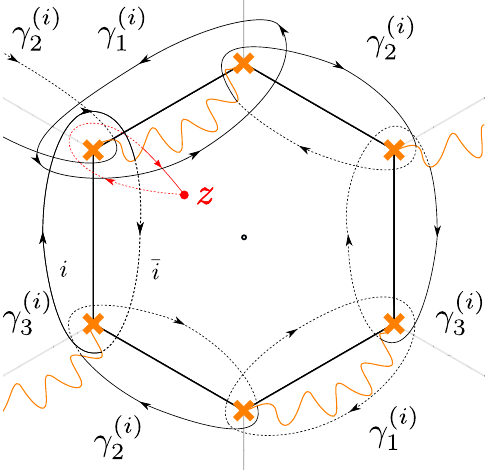
Figure 16. Charges of 2d-4d and 4d BPS states for a surface defect of the N = 2 (cid:3) theory. Paths on sheet i are denoted by solid lines, while paths on sheet (cid:22) { by dashed lines.